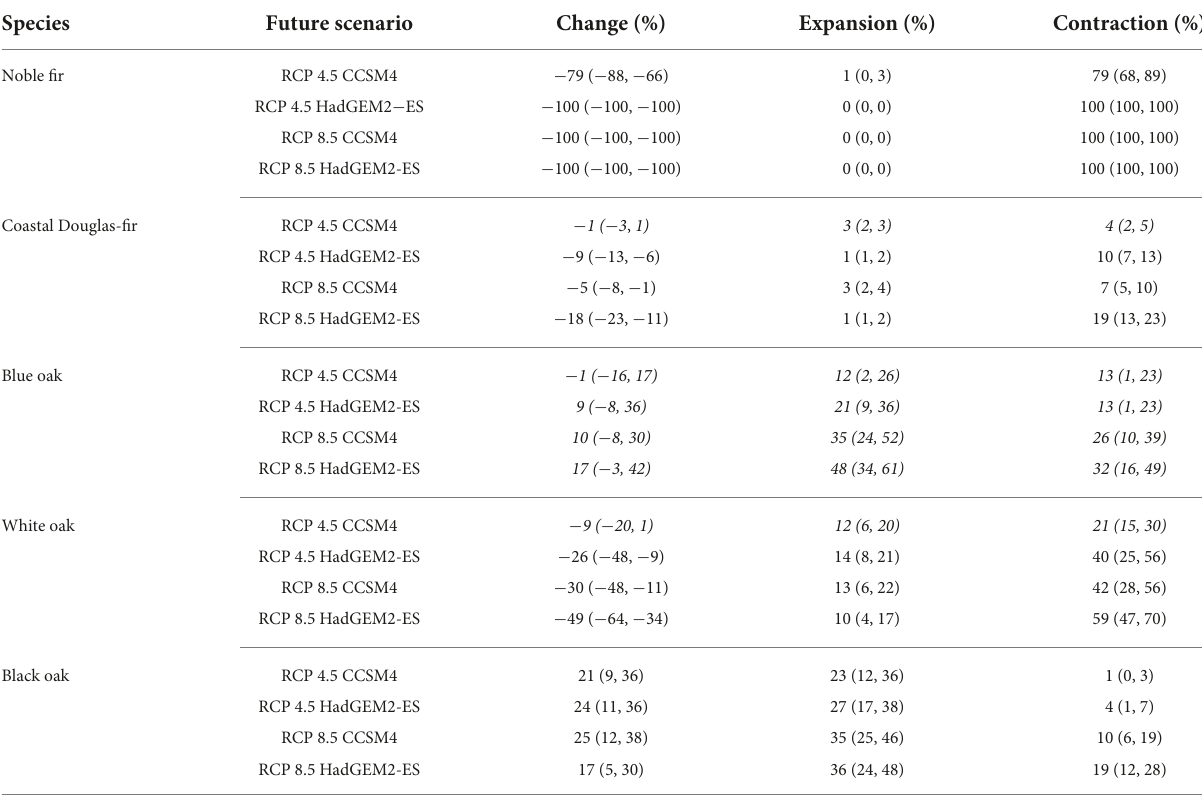
TABLE 3 Posterior means and equal-tailed 90% credible intervals for the relative-change (Change; %) in range-size estimates and the relative area of expansion and contraction (%; area relative to the current range-size estimate) by species under the four future climate scenarios. Species Noble